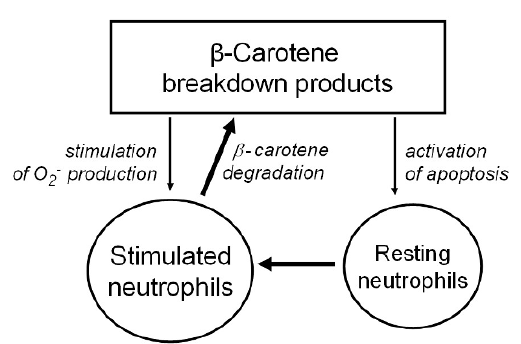
Figure 5. Mutual effects exerted by β -carotene breakdown products and neutrophils. Activated neutrophils are able to degrade β -carotene and generate a number of harmful carotenoid breakdown products. These compounds, in turn, stimulate superoxide production by neutrophils, while at higher concentrations they inhibit neutrophil functions by promoting cell